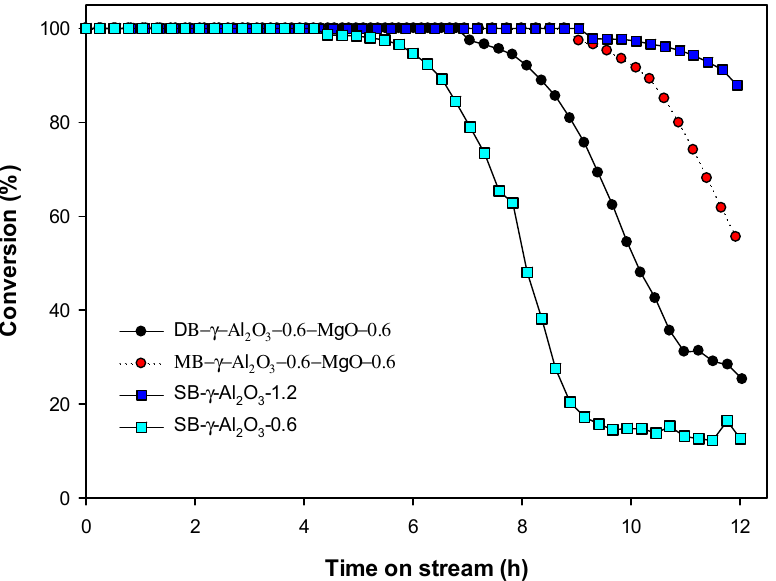
Figure 4. The changes of HFC-134a conversion efficiencies during long-term test over different catalyst beds for 12 hours at 600 ℃ ( SB- γ -Al 2 O 3 -1.2 , single bed- γ -Al 2 O 3 (1.2 g); DB- γ -Al 2 O 3 -0.6-MgO-0.6, double bed- γ -Al 2 O 3 (0.6 g) + MgO (0.6 g); MB- γ -Al 2 O 3 -0.6-MgO-0.6, mixed bed- γ -Al 2 O 3 (0.6 g) + MgO (0.6 g); SB- γ -Al 2 O 3 -0.6, single bed- γ -Al 2 O 3 (0.6 g)).